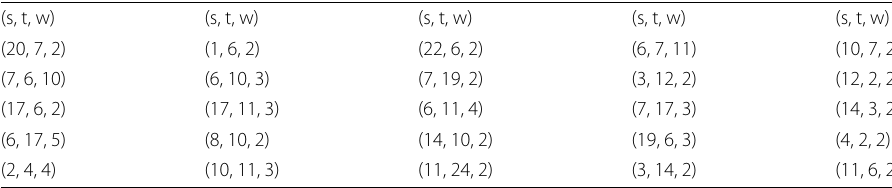
Table 17 A part of network weights in the PHN network of Fig.